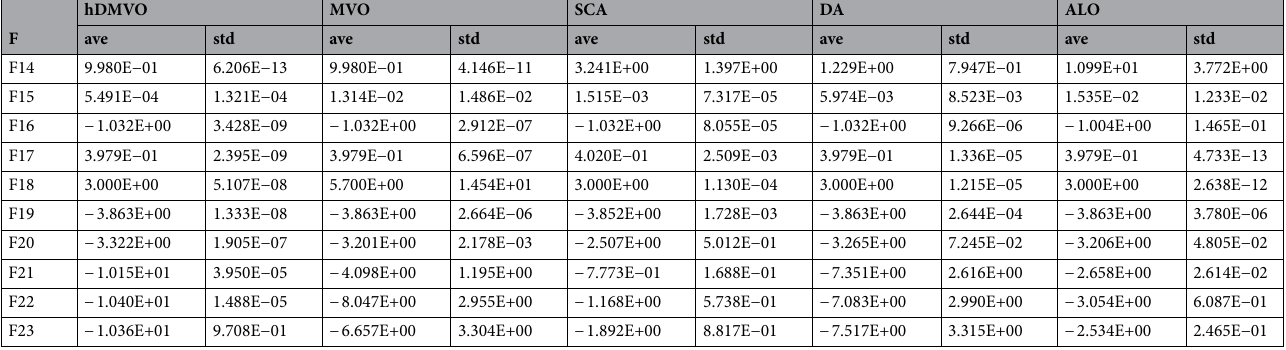
Table 7. Results of composite benchmark